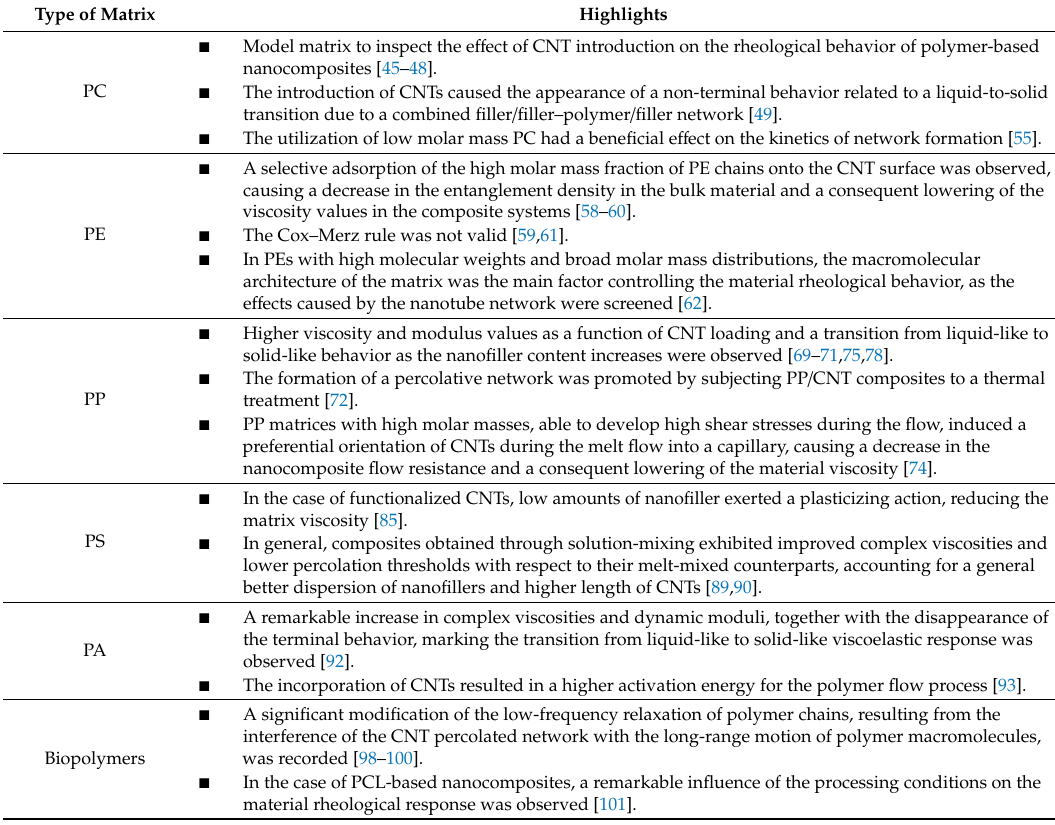
Table 2. Summary of the main achievements in the rheological behavior of CNT-containing thermoplastics. Type of Matrix